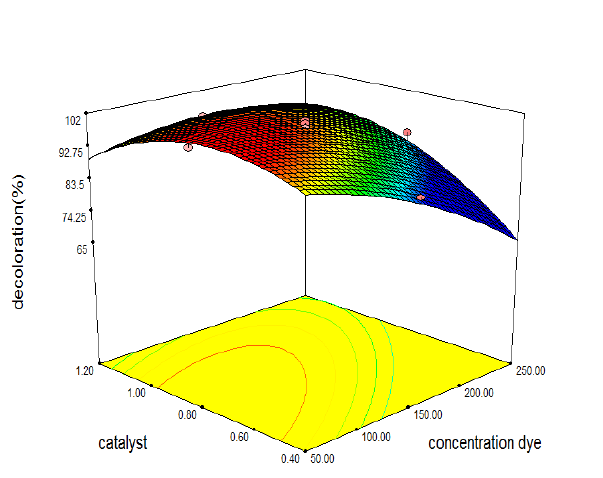
Figure 6. The effect of initial acid black 1 concentration (in mg/l) and nanoparticls (copper oxide doped zinc oxide) dose (in g/l) on decoloration of acid black 1 (pH = 6)